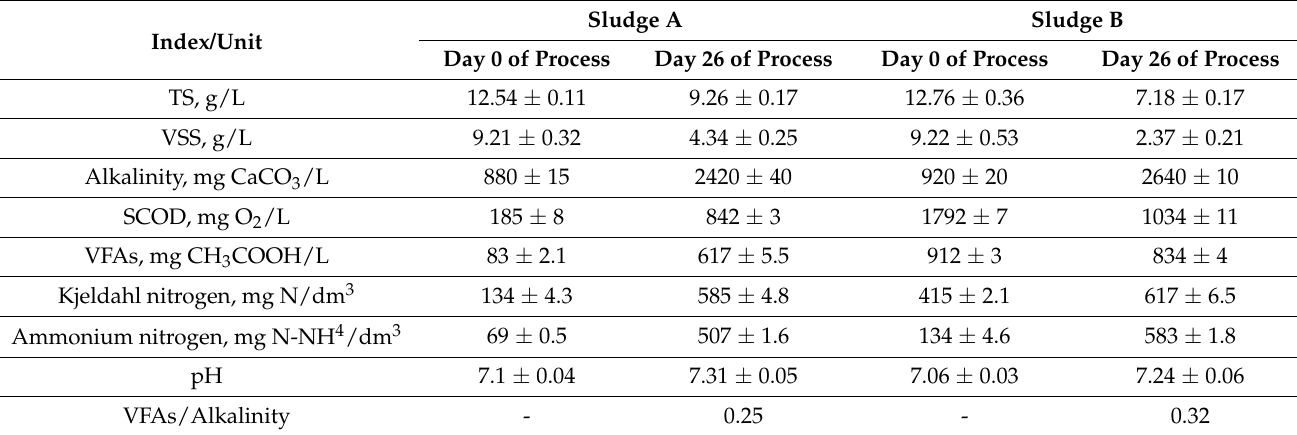
Table 3 shows selected physicochemical parameters obtained for conventional methane fermentation and methane fermentation of the sludge after disintegration. Table 3. Selected physicochemical parameters obtained for sludge A and B subjected to 26-day methane